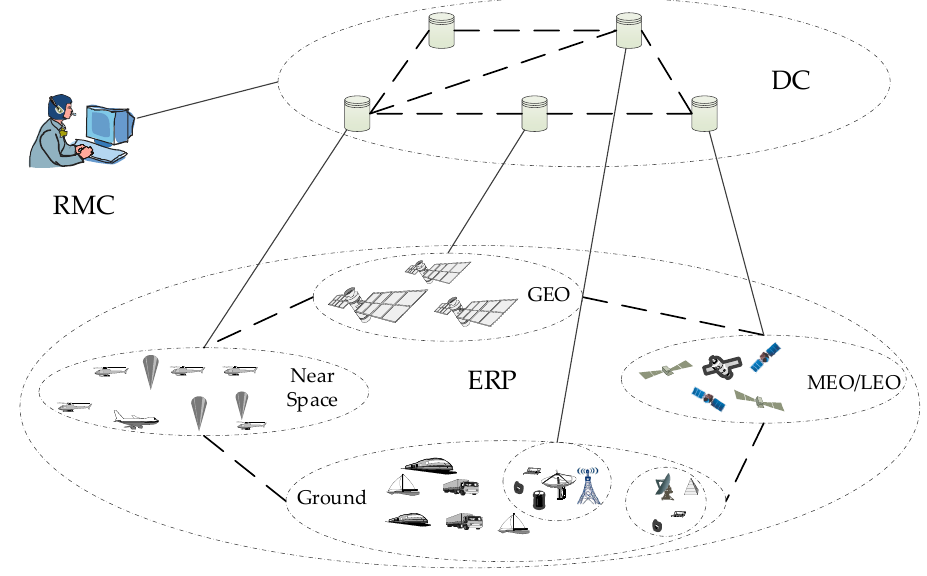
Figure 4. Reorganization SIN (R-SIN) framework.